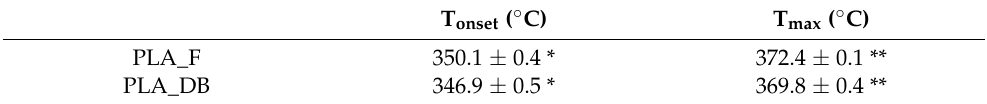
Table 4. Data relevant to TGA analysis.